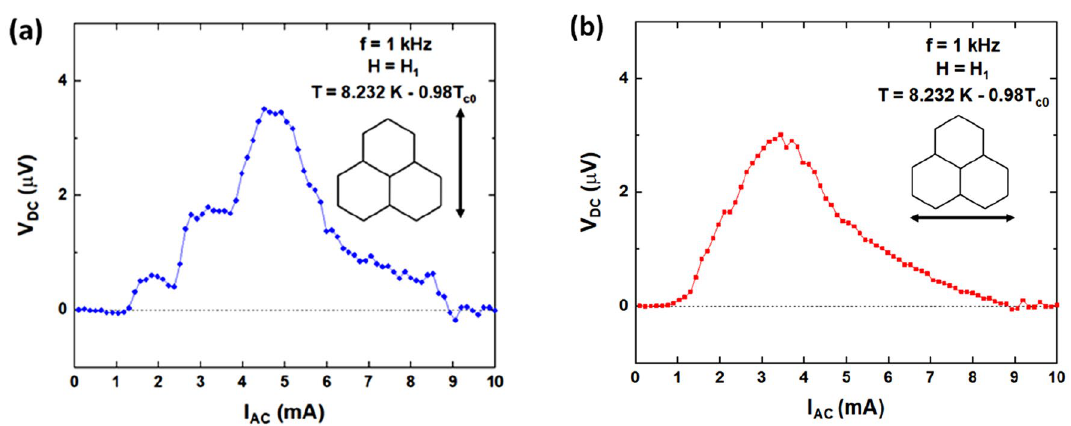
Figure 3. Ratchet effect at T/T c0 = 0.98 of sample B (remanent state magnetic selection protocol), applied magnetic field out of sample plane H 1 = 40 Oe (filling factor: one vortex per array unit cell). ( a ) Vortices moving parallel to easy axis. ( b ) Vortices moving parallel to hard axis. Insets show the direction of vortex